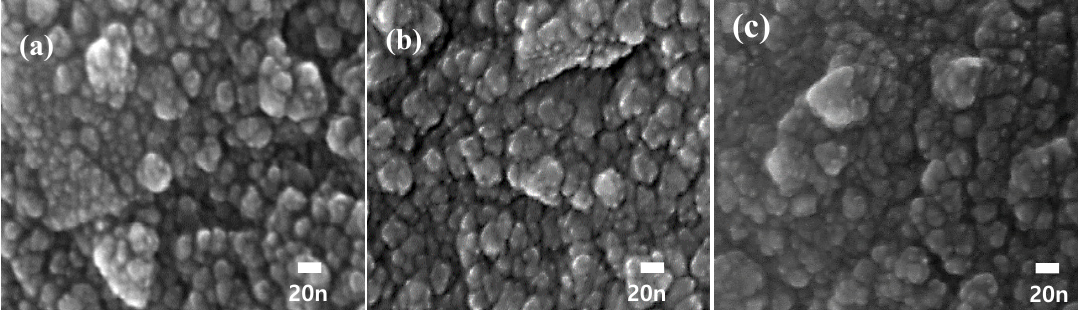
Figure 7. FE-SEM image of synthesized Ni 1 − x Zn x Fe 2 O 4 (x = 0.5, 0.6, 0.7) nanoparticles. ( a ) x = 0.5 ( b ) x = 0.6, and ( c ) x = 0.7.